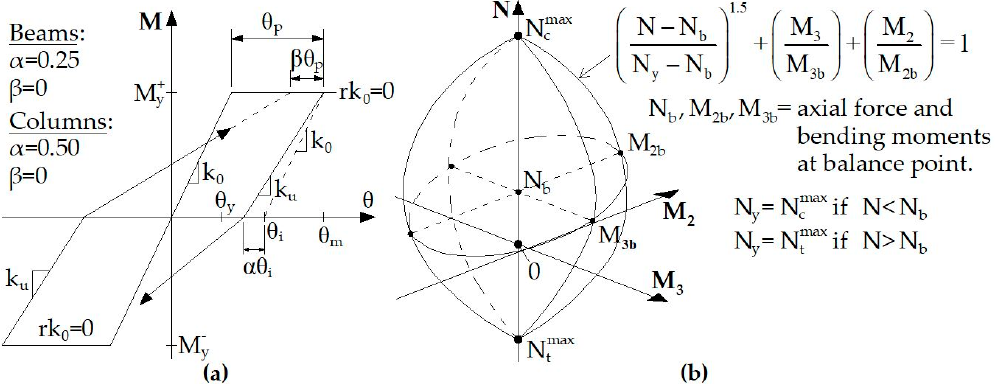
with an arbitrary plan view in Figure A4.